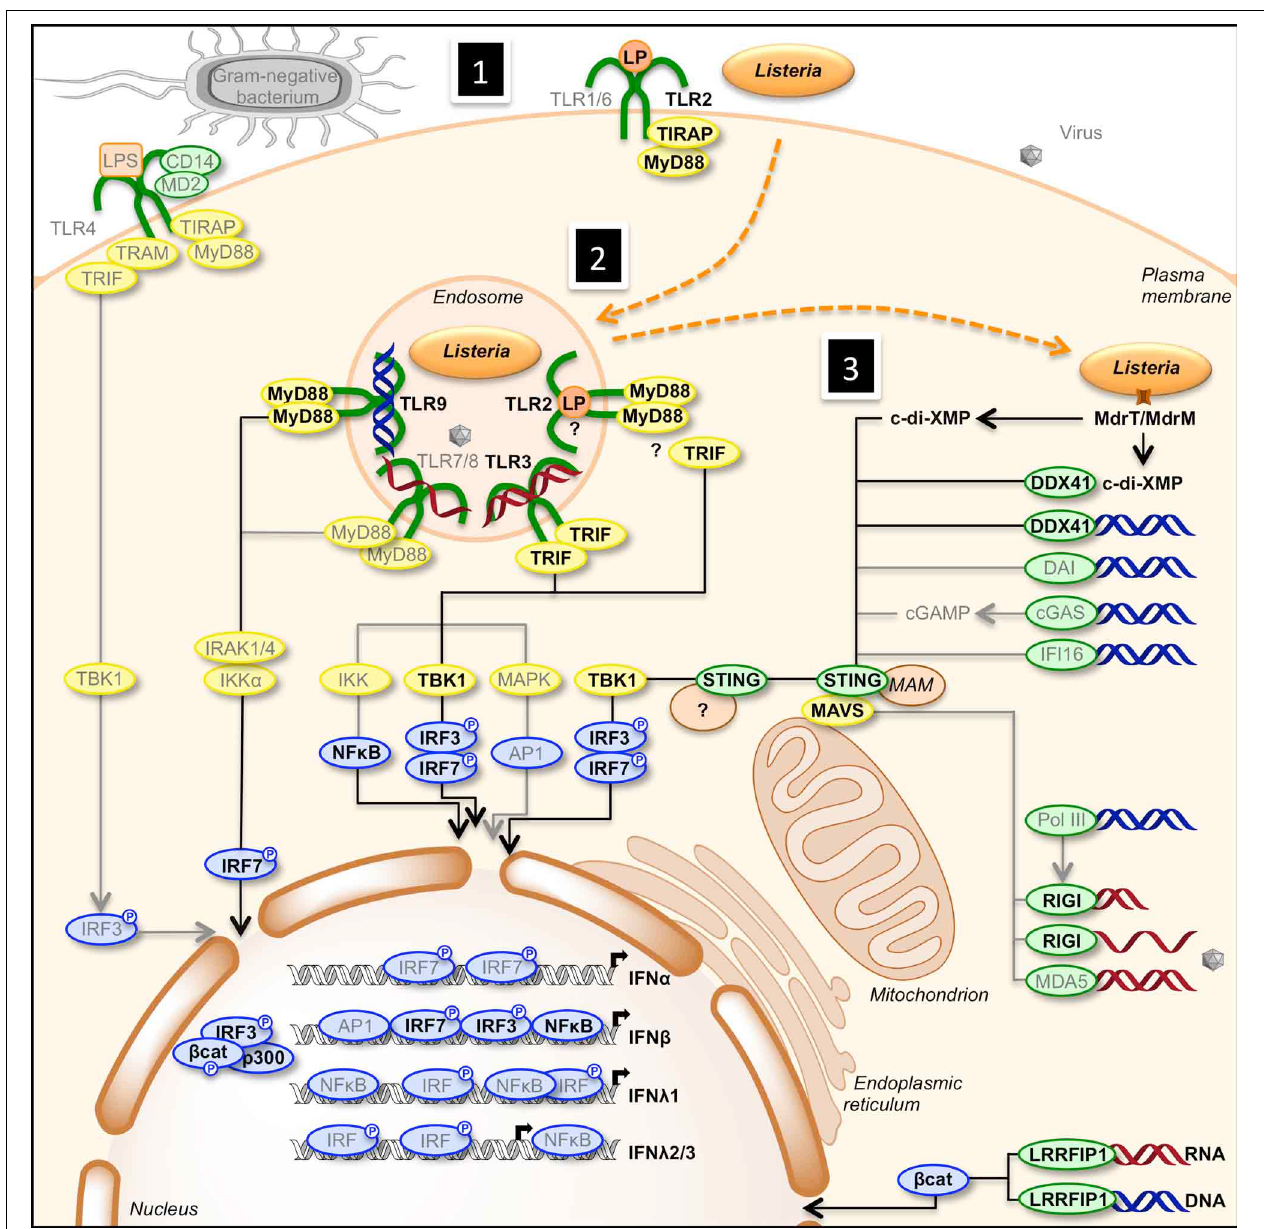
FIGURE 1 | Activation of type I- and type III-IFNs by infection. (1) Cells detect pathogens by membrane-bound PRRs of the TLR family, which trigger the IFN response. Infection of cells with extracellular Gram-negative bacteria leads to activation of TLR4/CD14/MD2 by LPS. Following TLR4 ligation, IRF3 is activated via the adaptors TRAM and TRIF, and TBK1. (2) Intracellular bacteria and viruses are recognized by TLRs located in the endosome. TLR2, TLR3, TLR7/8, and TLR9 detect lipoproteins, dsRNA, ssRNA, and unmethylated CpG DNA, respectively. Engagement of the receptors leads to the induction of MyD88- and TRIF-dependent pathways involving IKK-, TBK1-, and MAPK-mediated activation of NF- κ B, IRF3, IRF7, and AP1, ultimately resulting in transcriptional activation of IFN genes. (3) Infection of cells leads to the release of cyclic-di-nucleotides (c-di-XMP) and nucleic acids (RNA in red, DNA in blue) in the cytosol that signal the presence of microbes and induce expression of interferons. Cyclic-di-nucleotides secreted by bacteria, e.g., through multidrug resistance MdrT and MdrM in Listeria , can activate